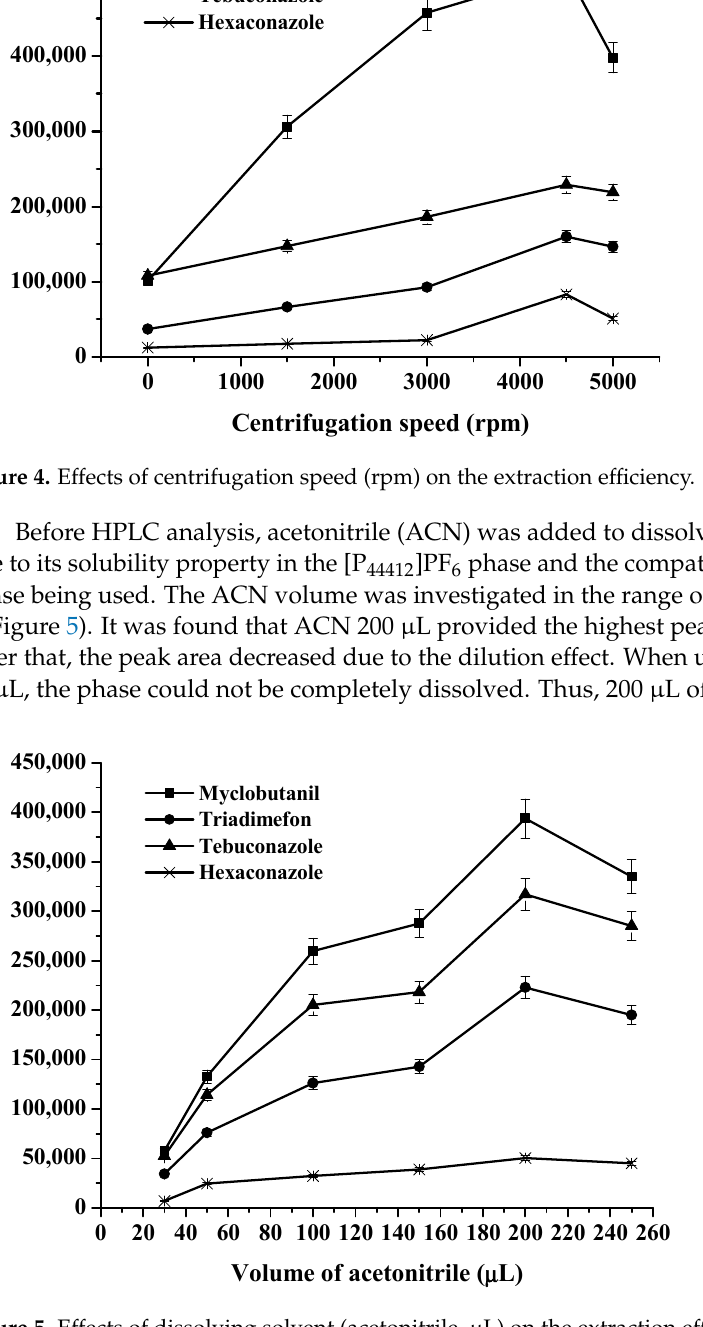
Figure 5. Effects of dissolving solvent (acetonitrile, µ L) on the extraction efficiency.